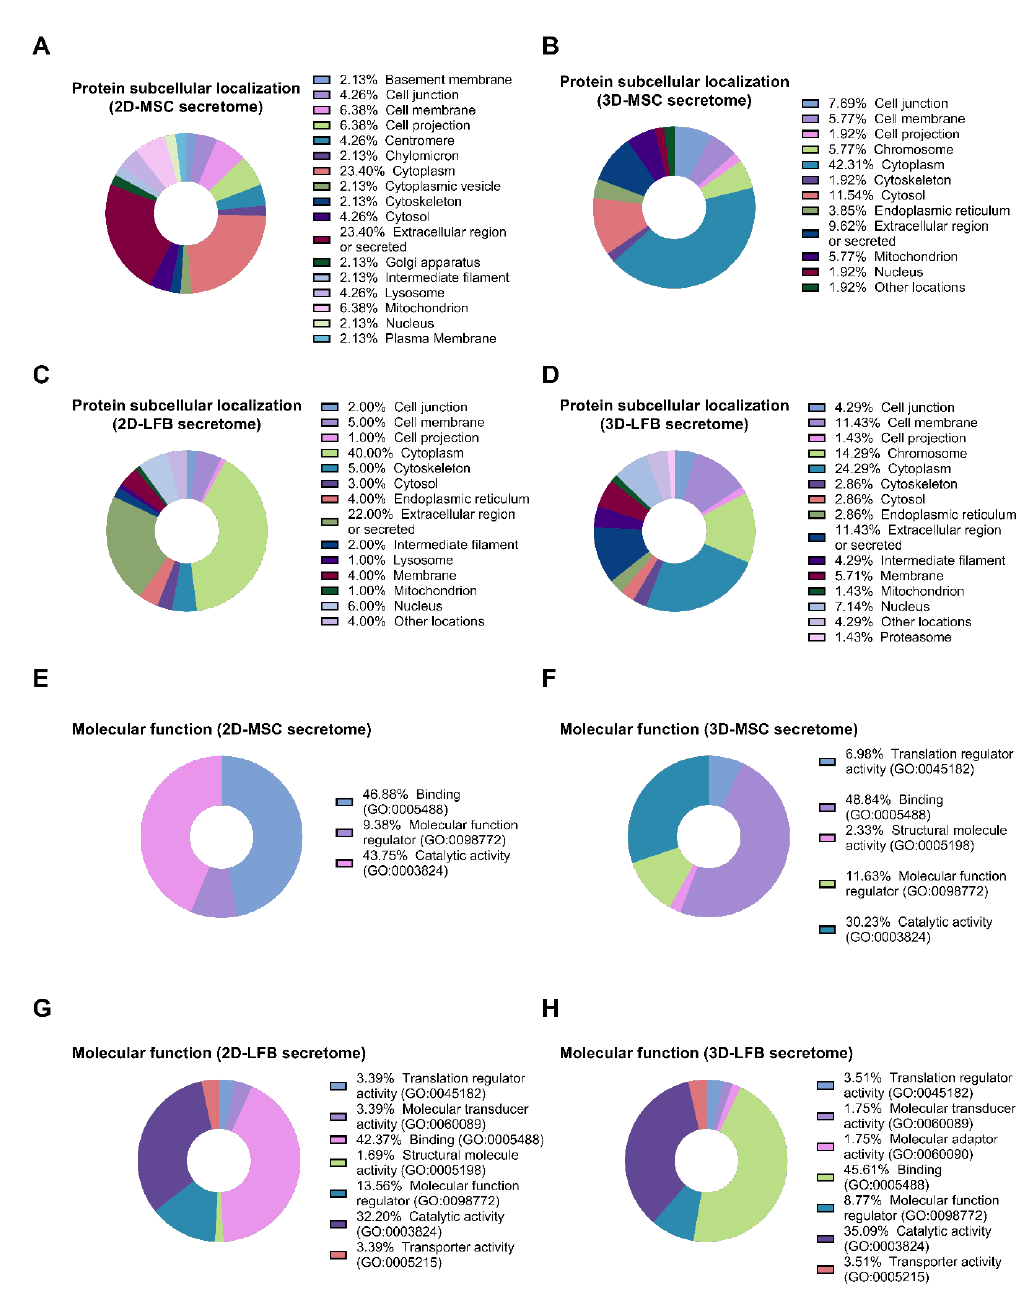
Figure 4. Proteomic analysis of multipotent mesenchymal stromal cell (MMSC) and lung fibroblast (LFB) secretomes. ( A ) Gene Ontology pie chart of subcellular localization of proteins identified only in the secretome from MMSC 2D cell culture. ( B ) Gene Ontology pie chart of subcellular localization of proteins identified only in the secretome from MMSC 3D cell culture. ( C ) Gene Ontology pie chart of subcellular localization of proteins identified only in the secretome from LFB 2D cell culture. ( D ) Gene Ontology pie chart of subcellular localization of proteins identified only in the secretome from LFB 3D cell culture. ( E ) Gene Ontology pie chart of molecular functions of proteins identified only in the secretome from MMSC 2D cell culture. ( F ) Gene Ontology pie chart of molecular functions of proteins identified only in the secretome from MMSC 3D cell culture. ( G ) Gene Ontology pie chart of molecular functions of proteins identified only in the secretome from LFB 2D cell culture. ( H ) Gene Ontology pie chart of molecular functions of proteins identified only in the secretome from LFB 3D cell culture. MMSC, multipotent mesenchymal stromal cell; LFB, lung fibroblast.